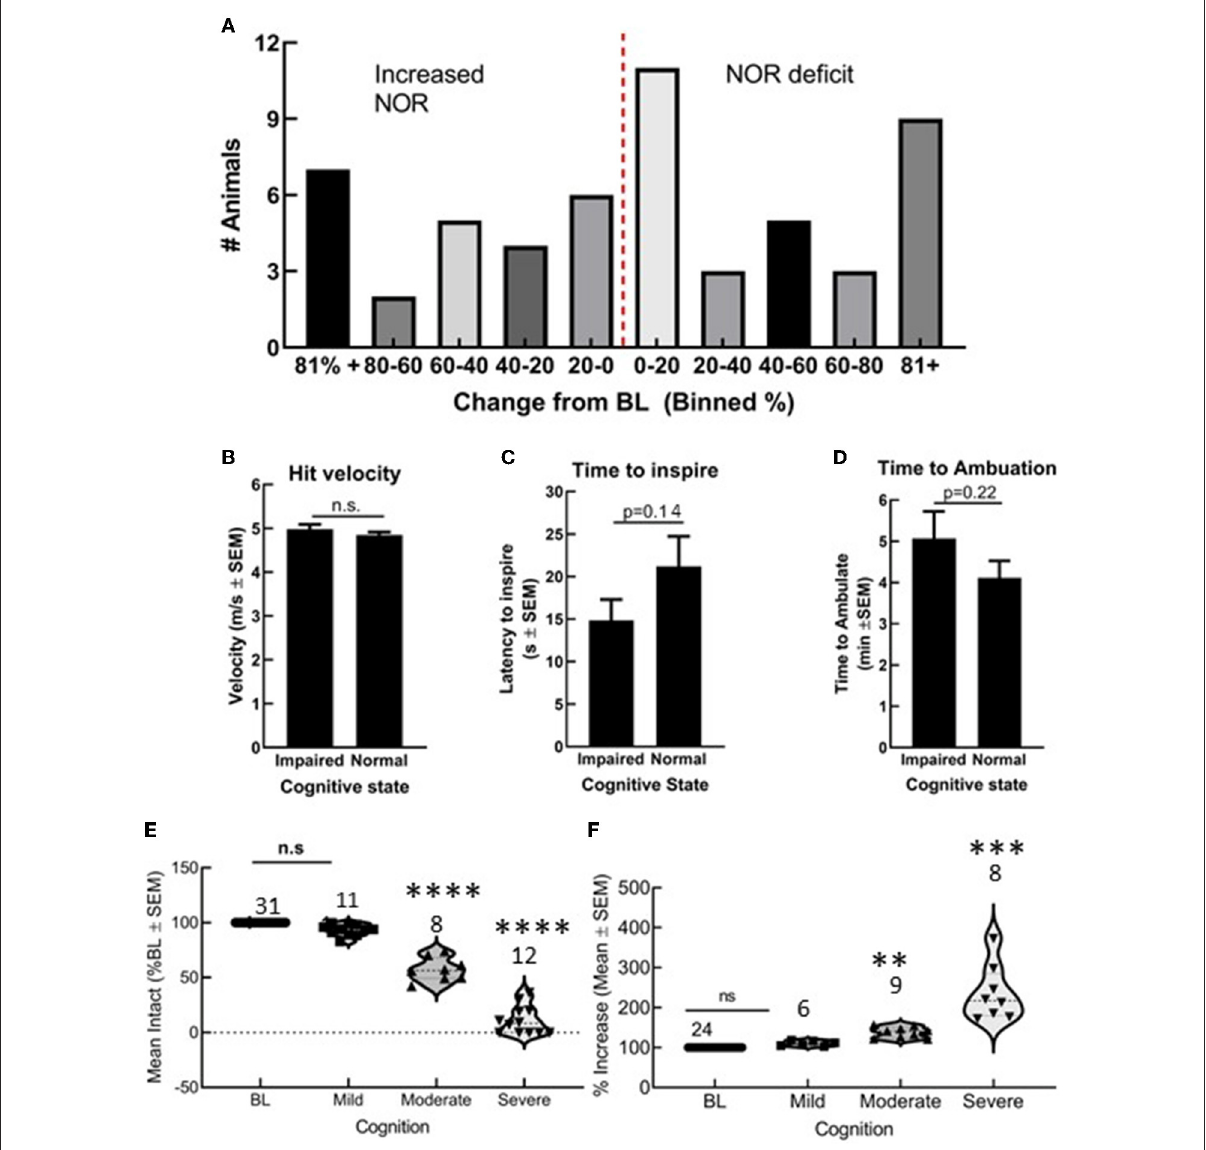
FIGURE1 Closed skull traumatic brain injury (TBI) induced variable cognitive outcomes as determined by novel object recognition (NOR). (A) Number of animals grouped by 20% bins showing both cognitive decline and cognitive improvement. Differences in (B) hit velocity, (C) time to inspire, and (D) time to ambulate port impact were not different between mice with cognitive impairment or normal cognition. (E,F) Animals with a mild TBI ( < 20% decline or impairment) performed similar to uninjured animals in NOR, whereas moderate and severe outcomes were statistically different from baseline. Statistically significant difference ( ** p < 0.01, *** P < 0.001, and **** P < 0.0001), n = 55